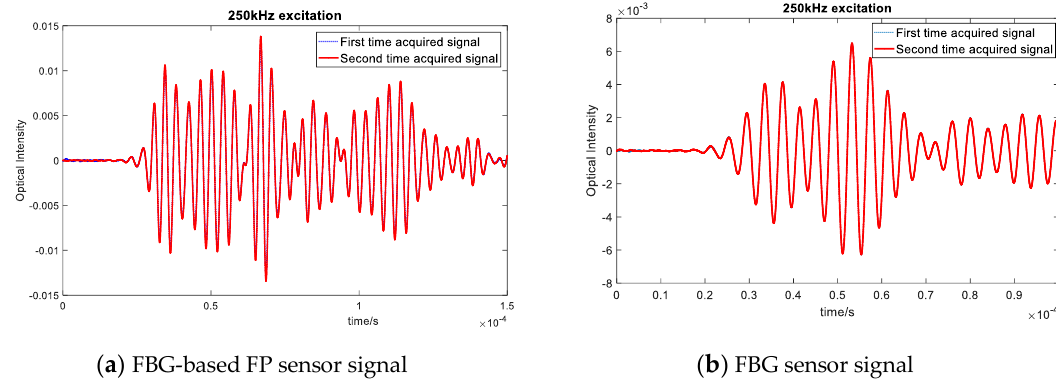
Figure 16. Processed data comparison between different environments.